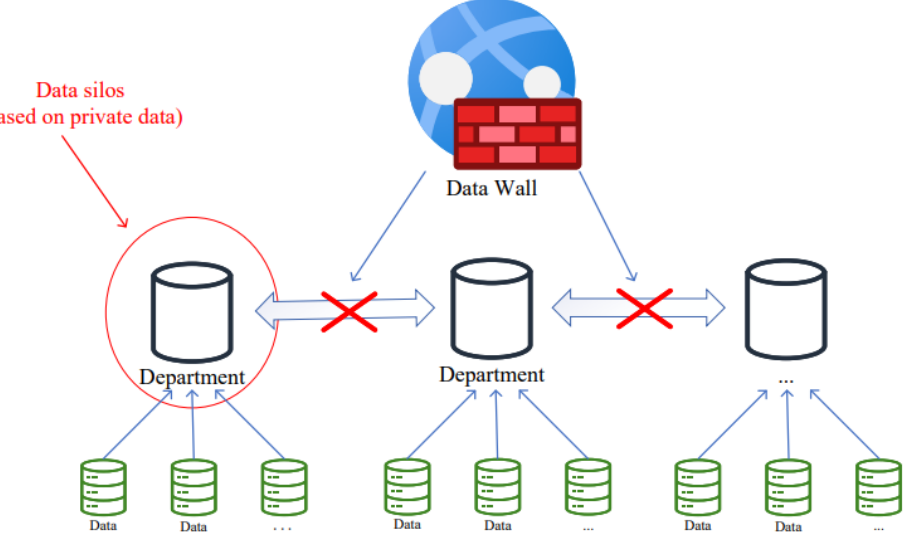
Figure 1. The data